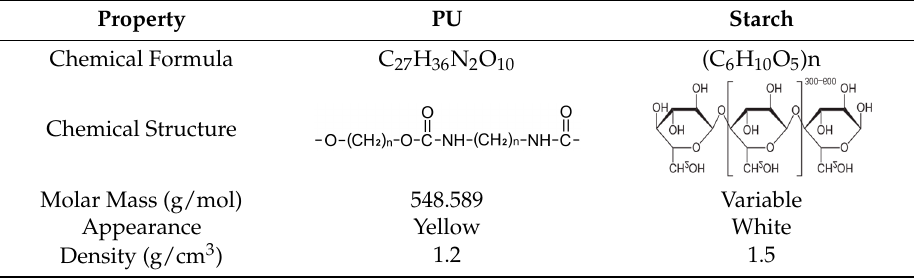
Table 2. Physical and chemical properties of PU and starch.